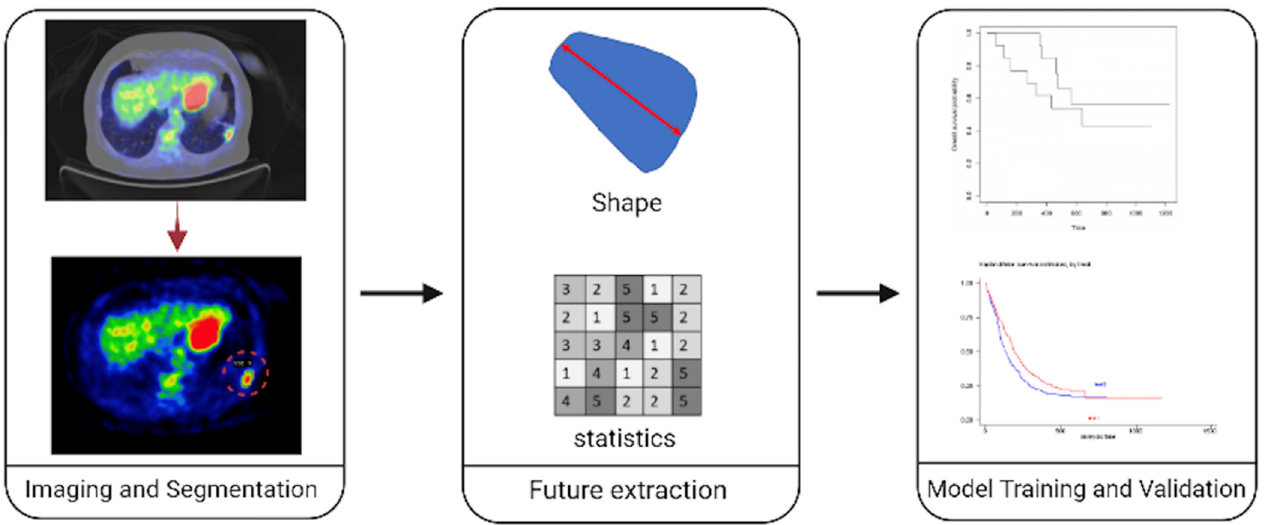
Figure 1. Typical workflow of a radiomic analysis. Initially, the proper medical imaging modality is selected (PET–CT in our example. Then, the radiologist segments the tissue of interest in all slices, resulting in a volume of interest. Consequently, radiomic features are computed using only the tissues included in the volume of interest. Such features can reflect shape information, signal intensities of tissues inside the VOI, and texture-related information that can reflect tissue heterogeneity. Finally, machine learning models are trained and validated to predict clinical outcomes or to classify patients according to genomic or molecular